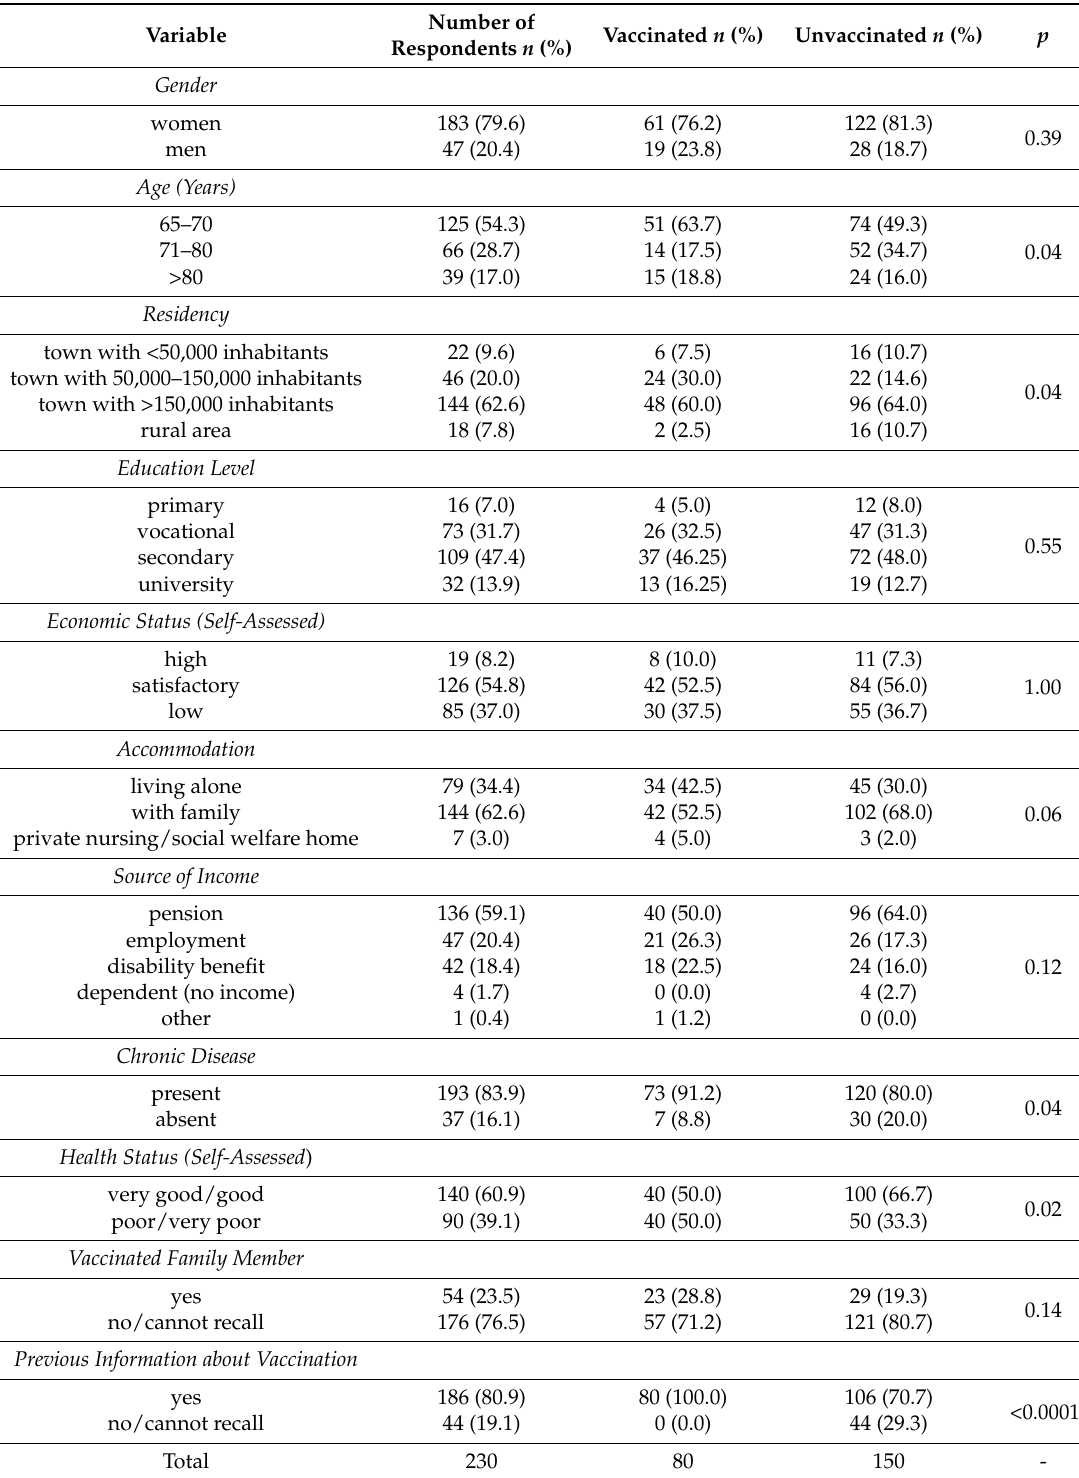
Table 1. Characteristics of elderly patients vaccinated and unvaccinated against influenza in Szczecin, Poland, 2015–2016; n =